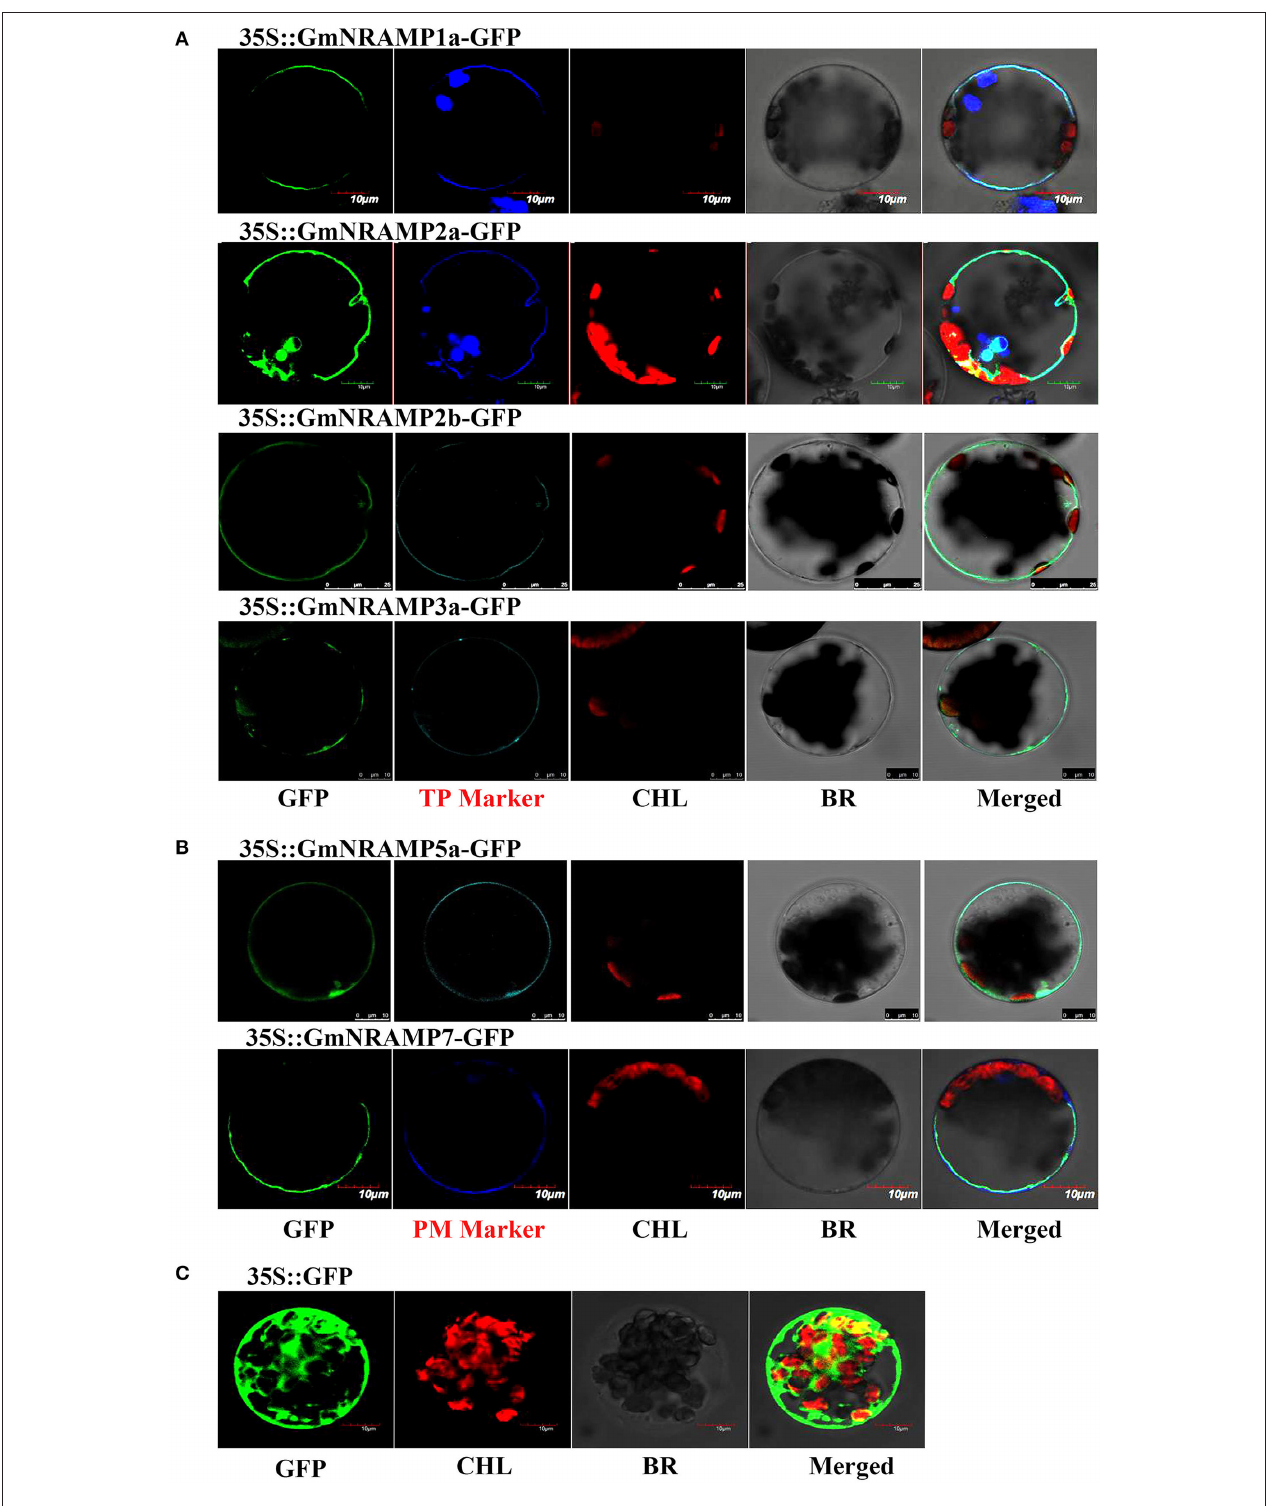
FIGURE 8 | Subcellular localization of selected GmNRAMP proteins in Arabidopsis thaliana protoplasts. Subcellular localization of GmNRAMP1a, GmNRAMP2a, GmNRAMP2b, GmNRAMP3a, GmNRAMP5a and GmNRAMP7 was assessed in Arabidopsis protoplasts transiently transformed with 35S::GmNRAMP-GFP constructs. The tonoplast marker (TP Marker) AtTPK1 was included with 35S::GmNRAMP1a, 2a, 2b, 3a-GFP constructs (A) , and the plasma membrane marker (PM Marker) OsMCA1 was included with 35S::GmNRAMP5a and 7-GFP constructs (B) . 35S::GFP was included as a control (C) . GFP, green fluorescence signal; CHL, chloroplast; BR, bright field; Merged: GFP, CHL, Marker, and BR overlay.